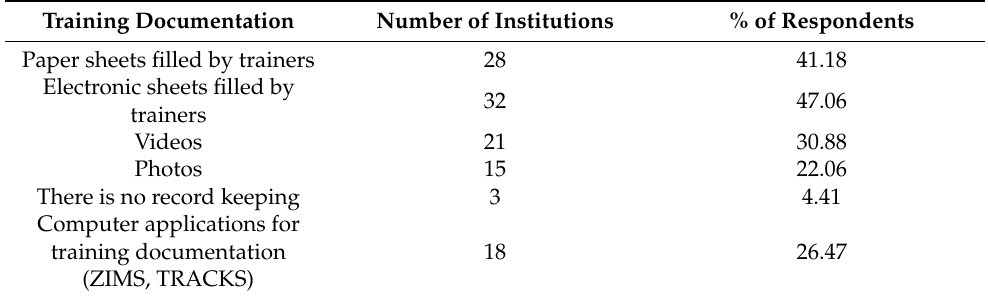
Table 6. Training documentation and record-keeping used in North American institutions ( n = 68).